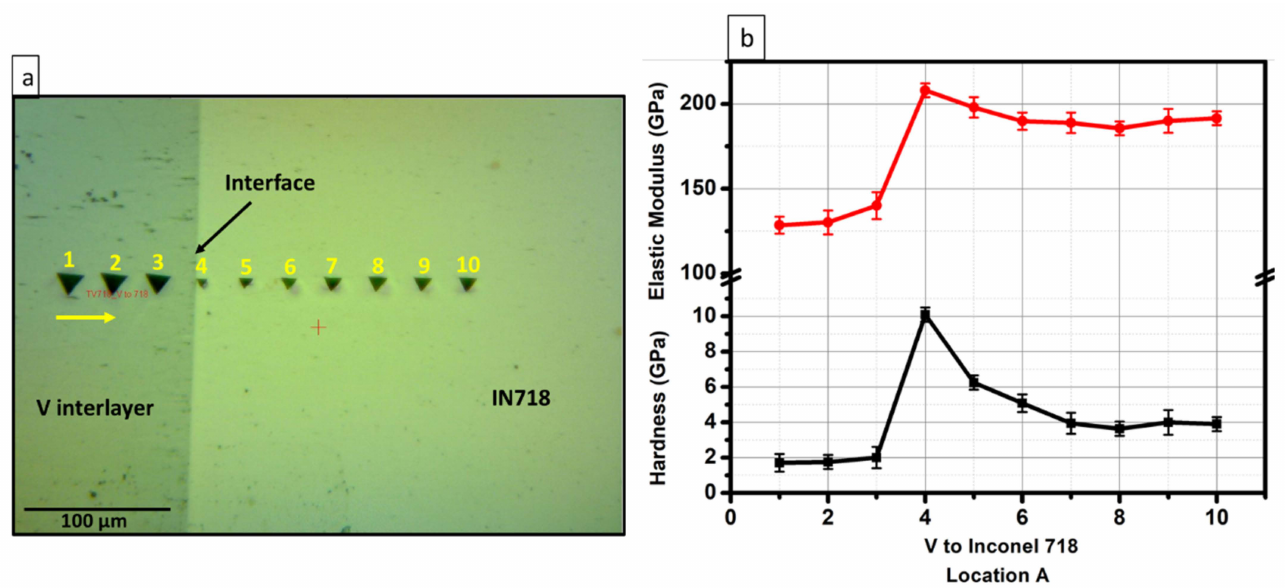
Figure 9. ( a ) Nanohardness line scan at the V/IN718 Interface (location (A) in Figure 8)). ( b ) Corresponding hardness and elastic modulus profiles along the line